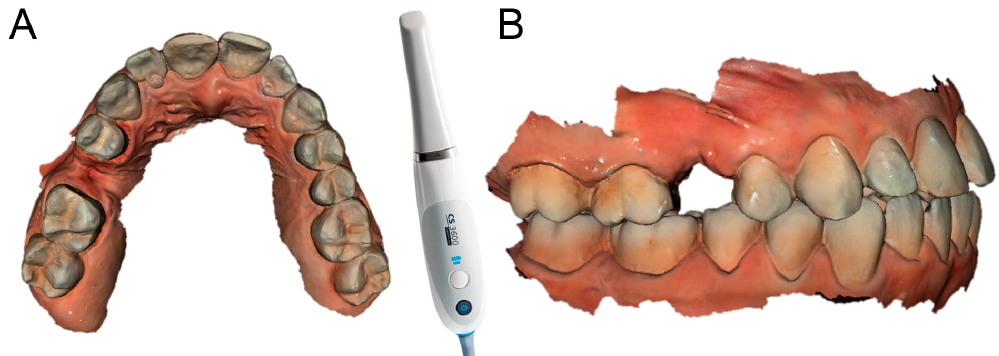
Figure 1. Intraoral scan CS 3600 ® (Carestream Dental, Atlanta, GA, USA). The second right premolar